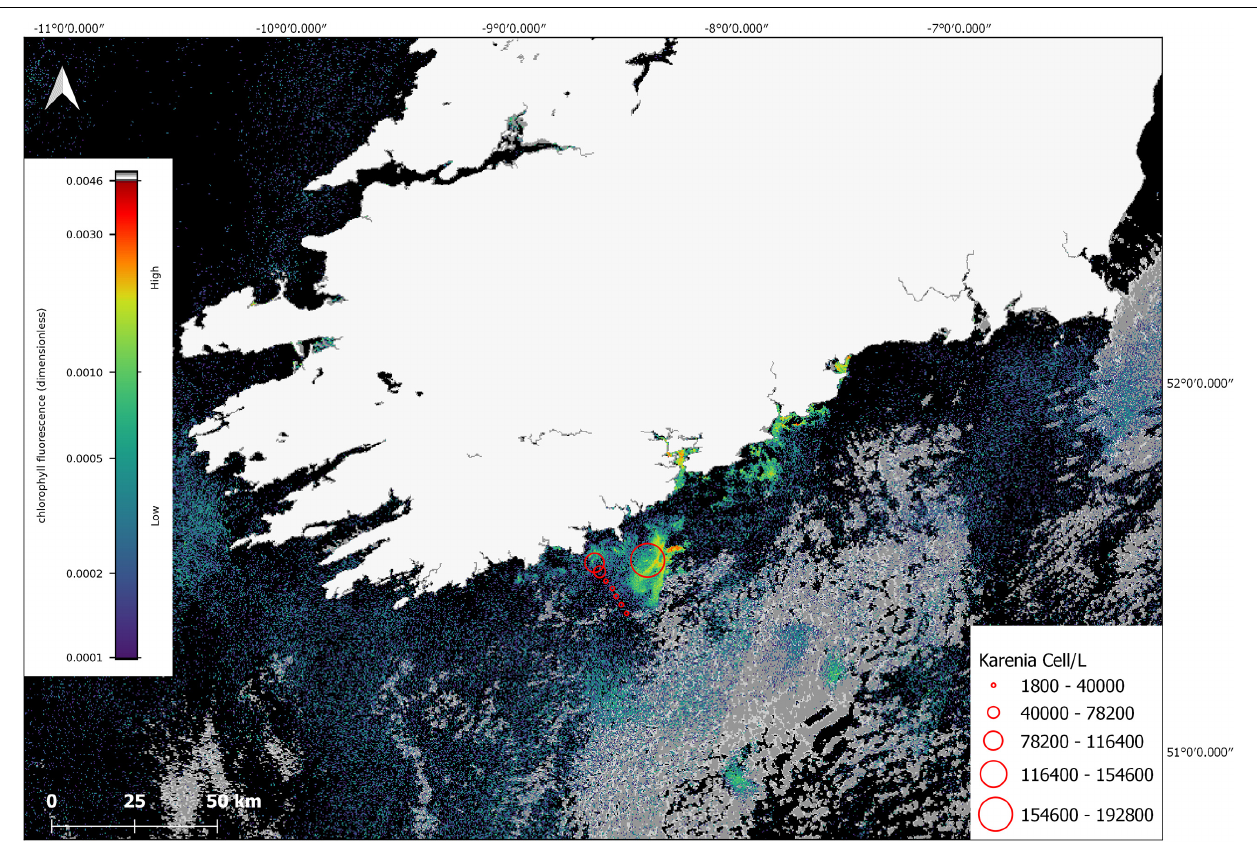
FIGURE 6 | Sentinel-3a OLCI image with RBD algorithm from 10 July 2019. The red circles indicate cell concentrations determined using light microscopy for in situ samples collected on CV19018 on the same date. The grey colour in the image represents cloud cover.